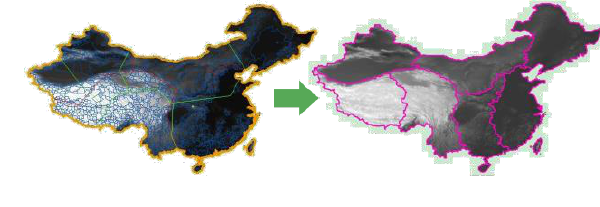
Figure 7. Forming a nationwide Eco-geographical